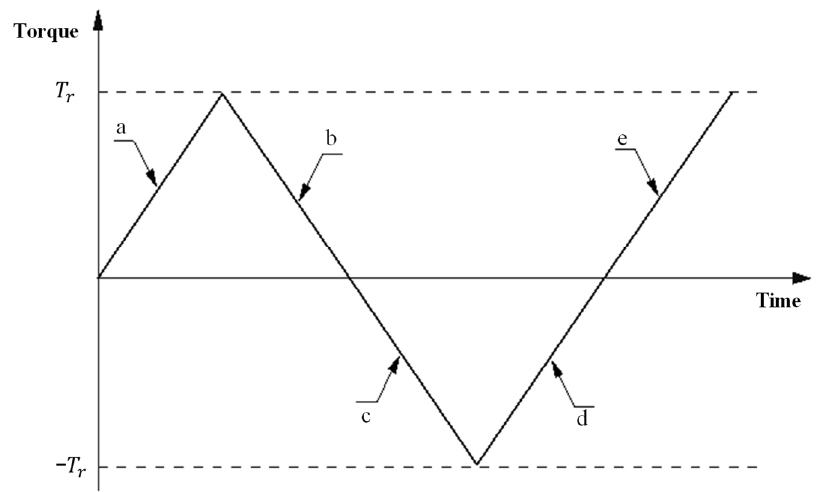
Figure 10. Test step.